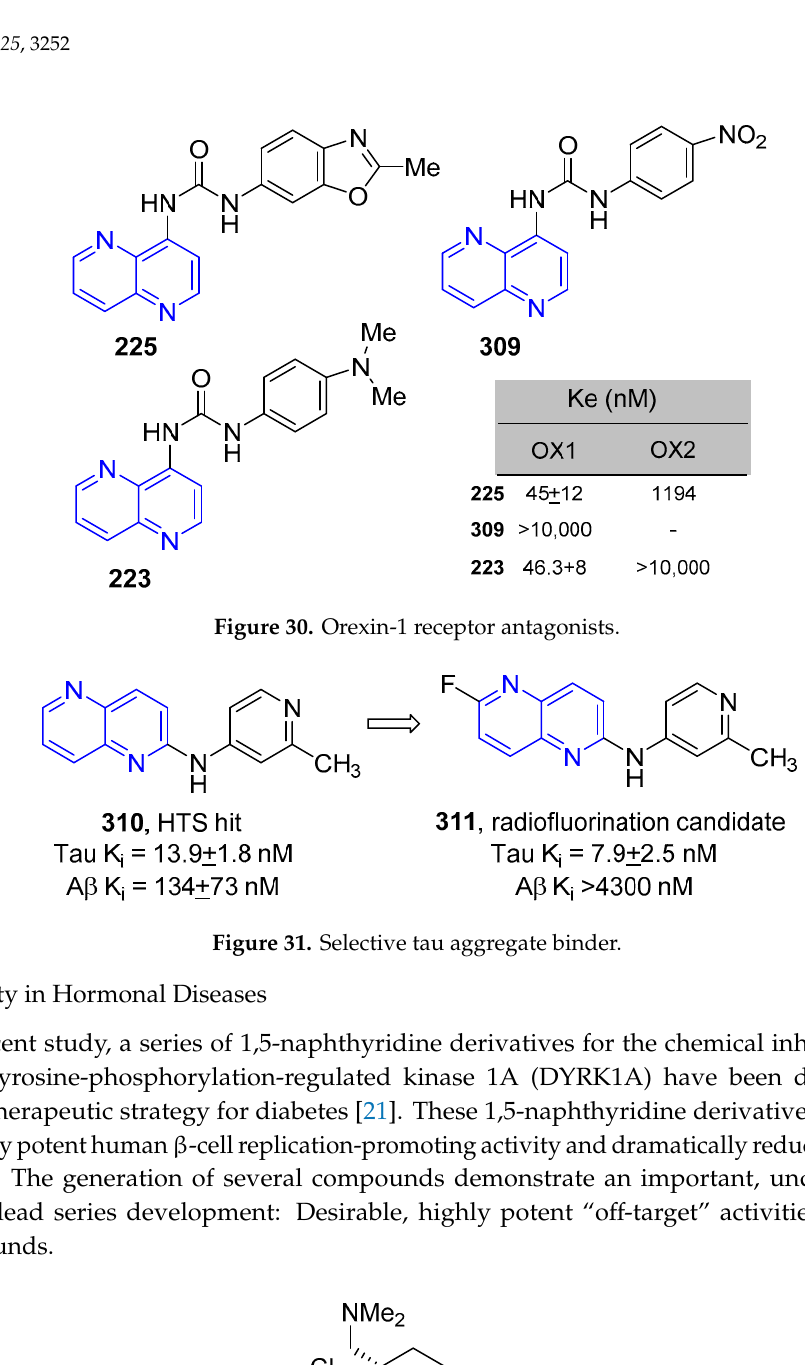
Figure 31. Selective tau aggregate binder.